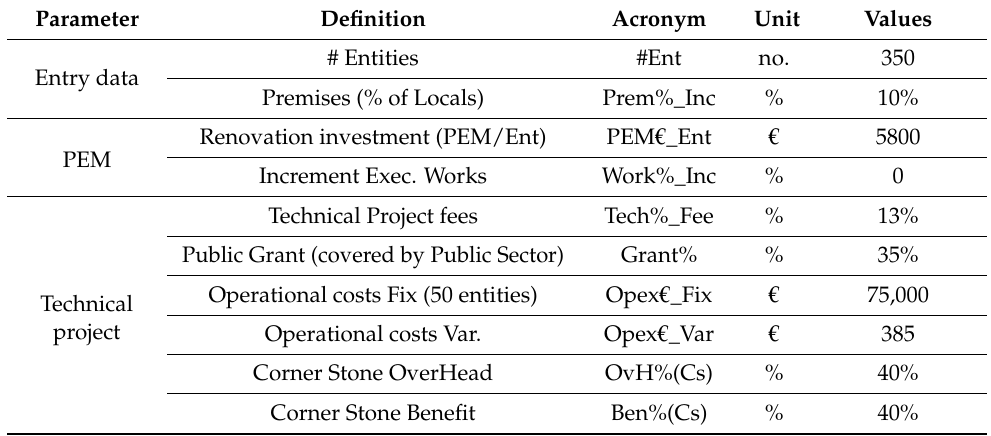
Figure 8. Extract of the PEDRERA sensitive analysis on the financial appraisal KPIs: the end-user perspective (UT2 monthly rate fee) and the Public Sector perspective (City revolving funds size) to cover vulnerable type users. Table 5. List of input from Santa Coloma test bed, adopted as a baseline in the financial appraisal (Figure 8). Source: